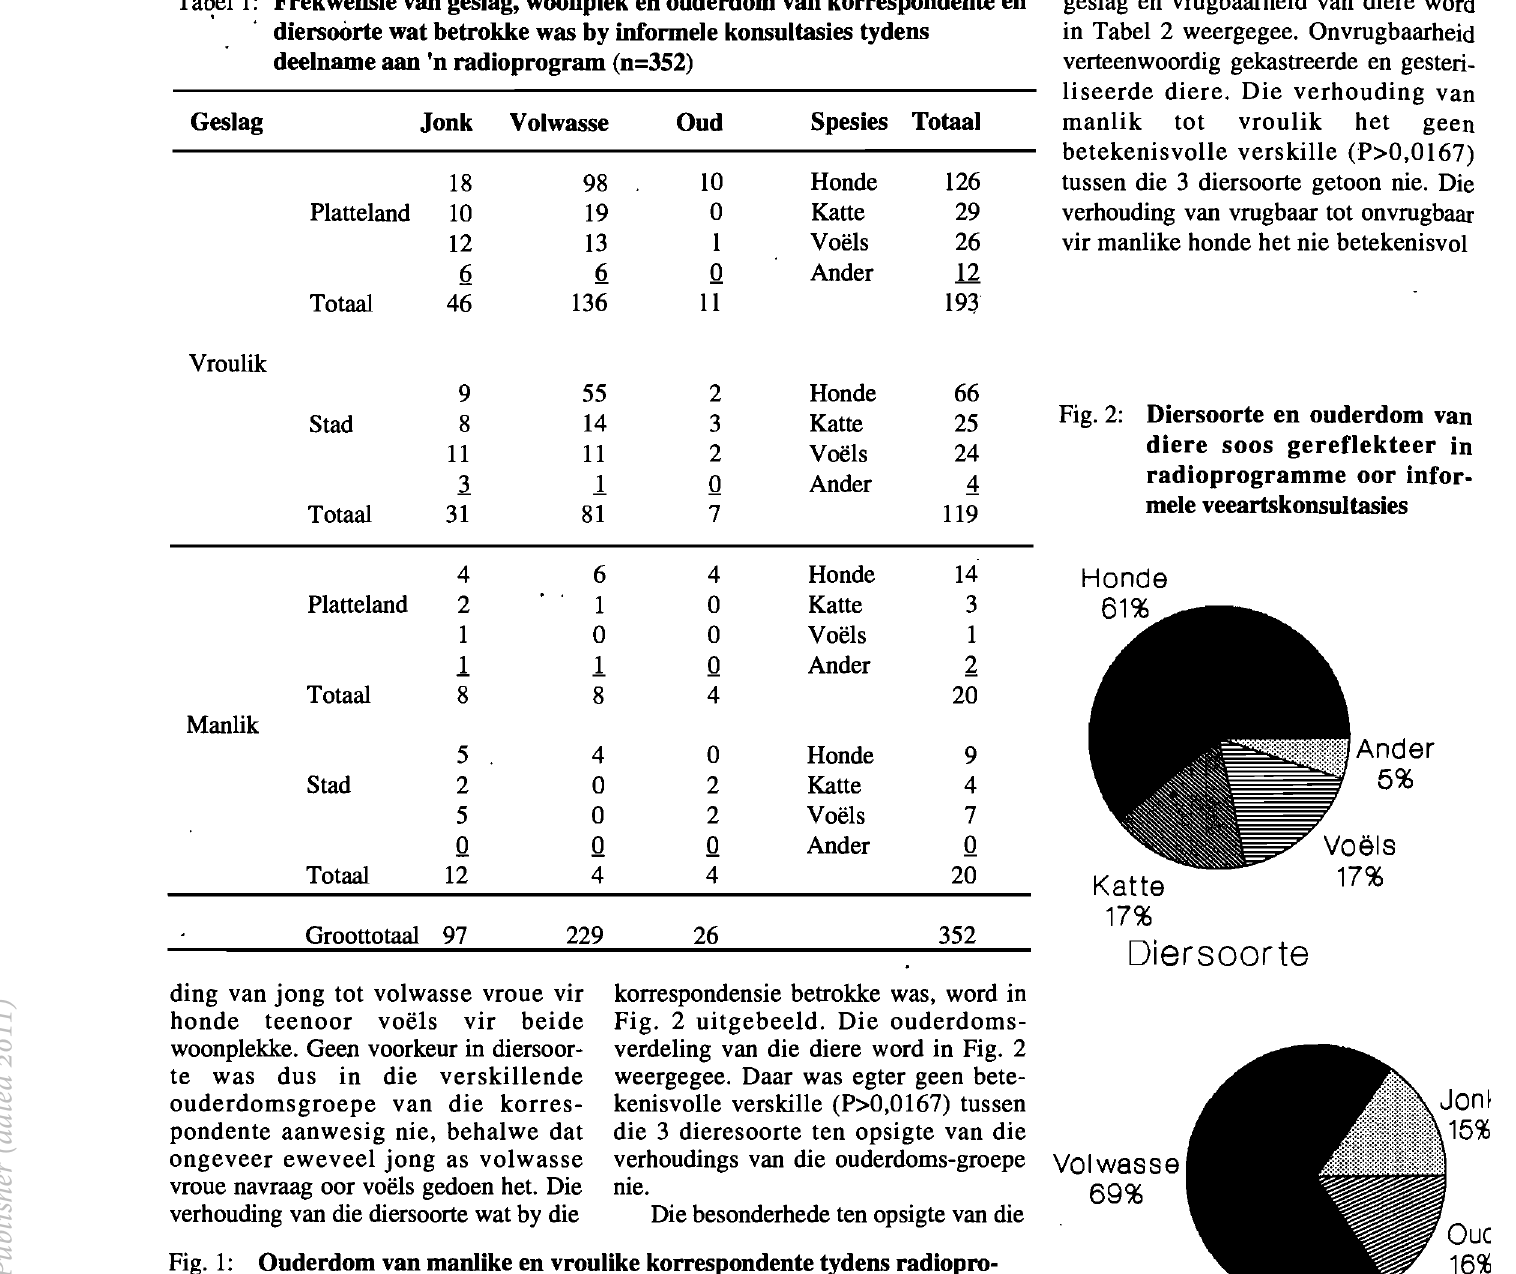
Fig. 1: Ouderdom van manlike en vroulike korrespondente tydens radiopro